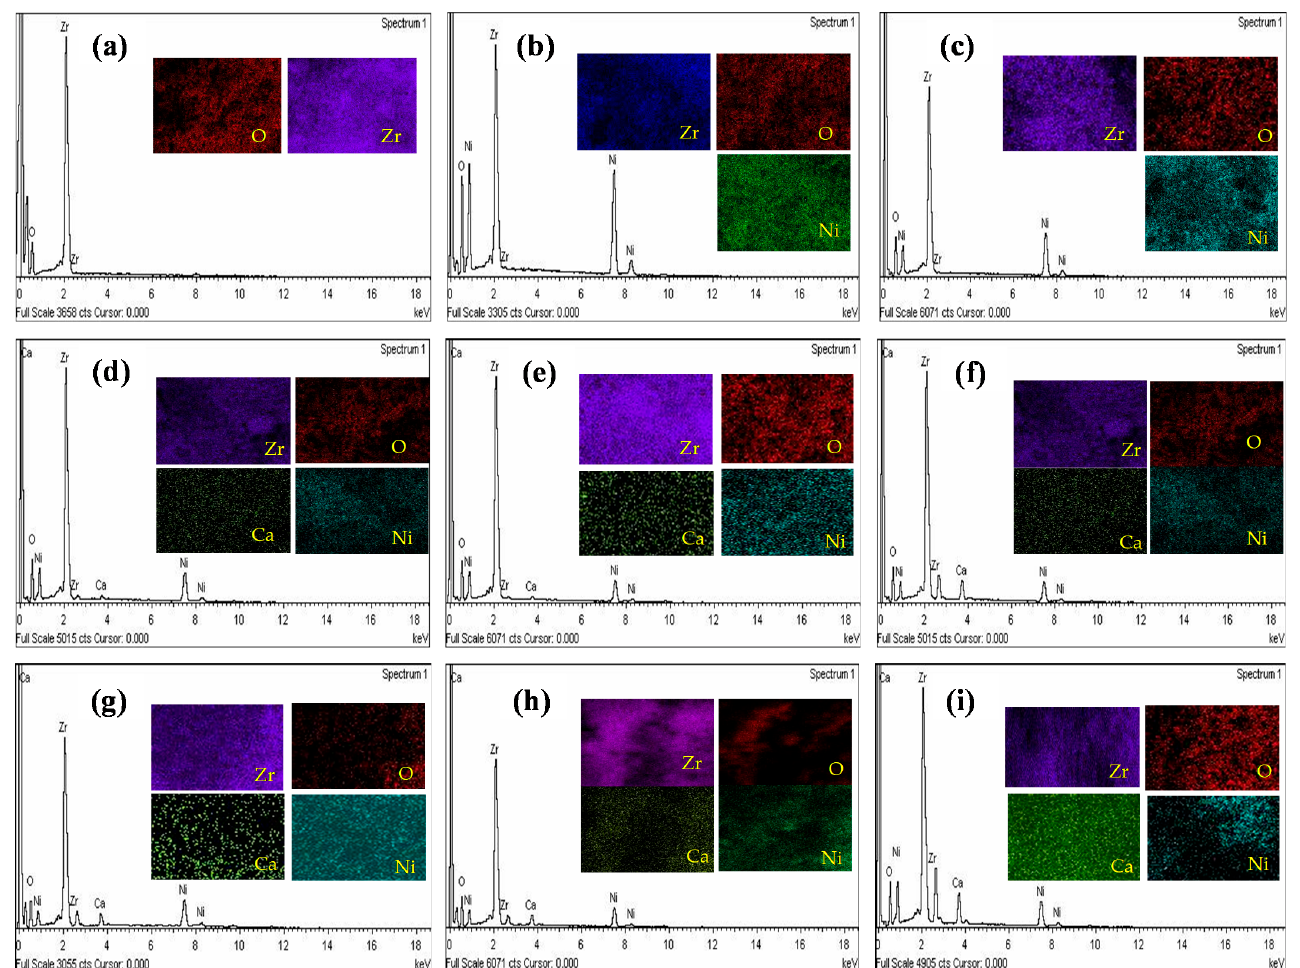
Figure 3. EDX spectra and dot mapping images of all the synthesized catalysts: ( a ) ZrO 2 , ( b ) 10%Ni/ZrO 2 _WI, ( c ) 10%Ni/ZrO 2 _Us, ( d ) 10%Ni-0.5%Ca/ZrO 2 _Us, ( e ) 10%Ni-0.5%Ca/ZrO 2 _WI, ( f ) 10%Ni-3%Ca/ZrO 2 _Us, ( g ) 10%Ni- 3%Ca/ZrO 2 _WI, ( h ) 10%Ni-5%Ca/ZrO 2_ Us, and ( i ) 10%Ni-5%Ca/ZrO 2_ WI.